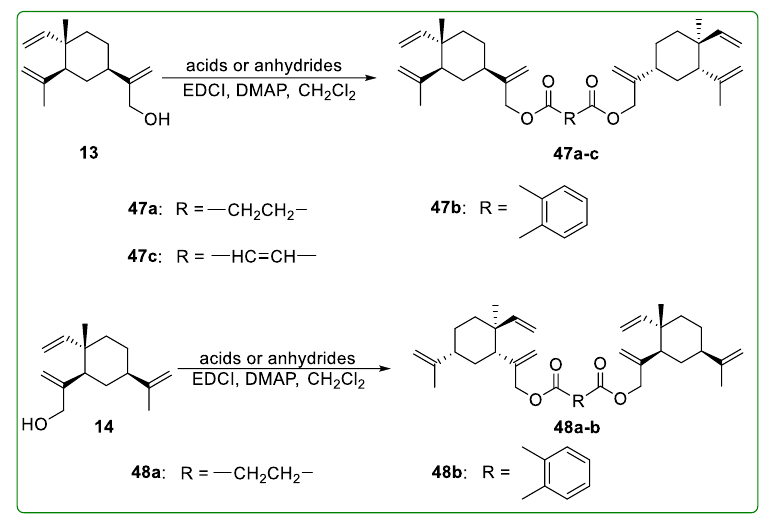
Figure 16. Chemical structures of β -elemene ester derivatives 47a – c and 48a – b .